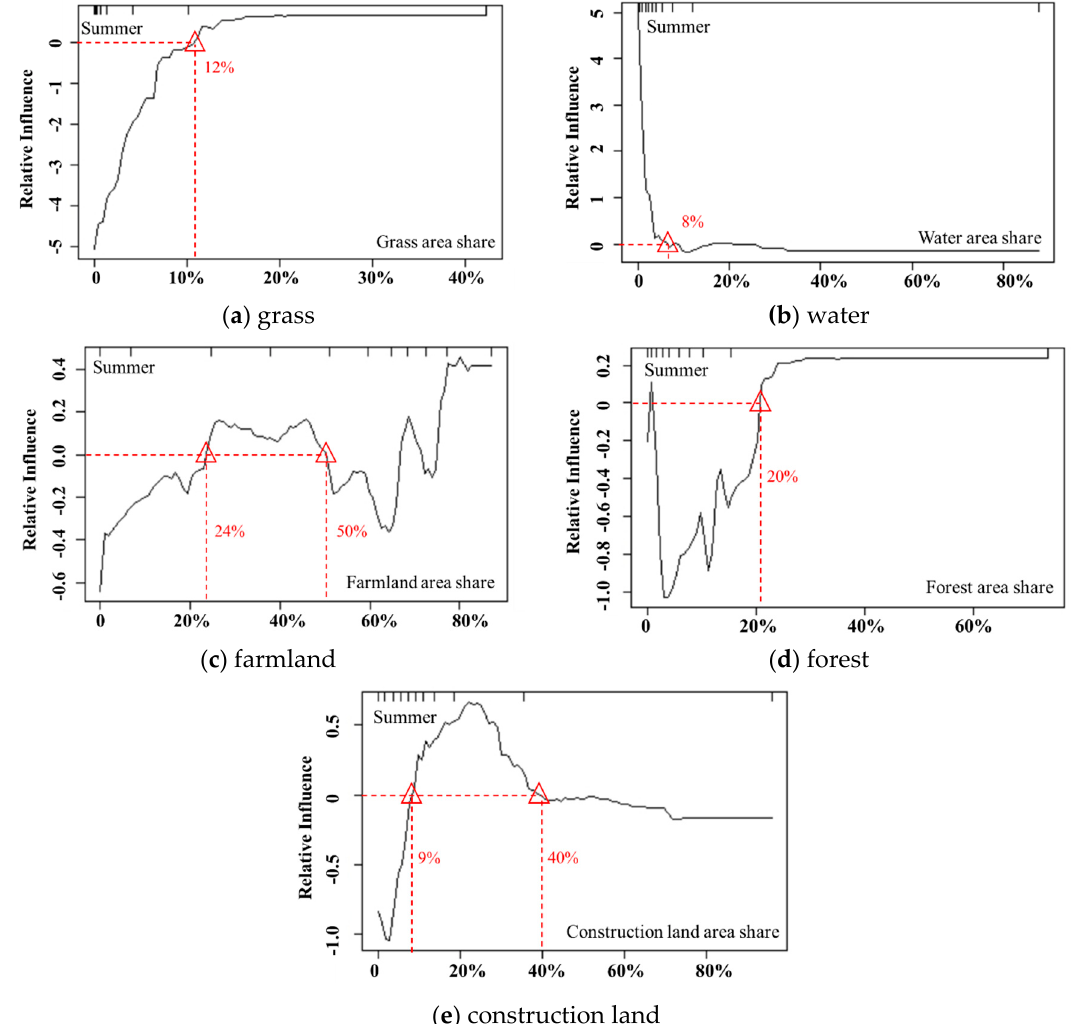
Figure 8. The influence of the main factors (concentration rate >10%) on PM 2.5 in